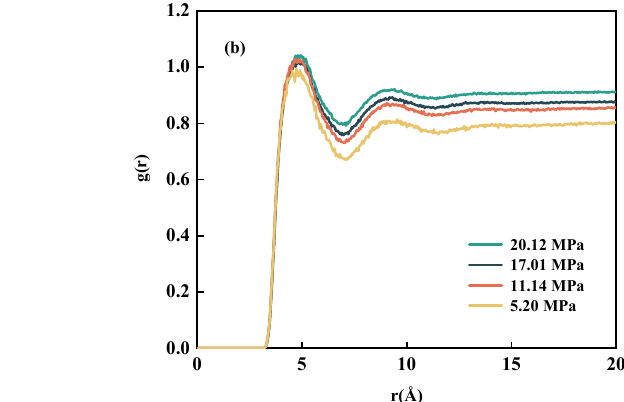
10 of 13 Figure 10. MSD of n-decane/CH 4 at different pressures at 313.3 K. ( a ) N-decane; ( b ) CH 4 . The radial distribution functions of CH 4 and n-decane in the binary system under